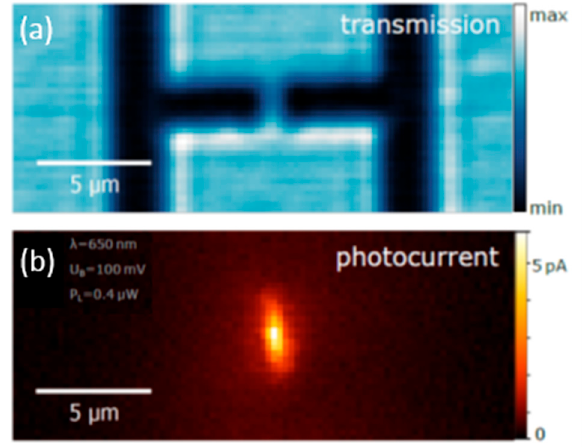
Figure 1. Scanning photocurrent microscopy: ( a ) optical transmission image of gold electrodes on glass with a 1 µm-wide gap, covered with a layer of PbS quantum dots; ( b ) simultaneously acquired photocurrent image, with illumination parameters as given in the